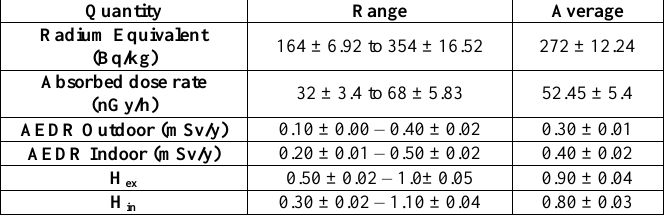
Table 2: Radiological Results for the Tailing Samples.